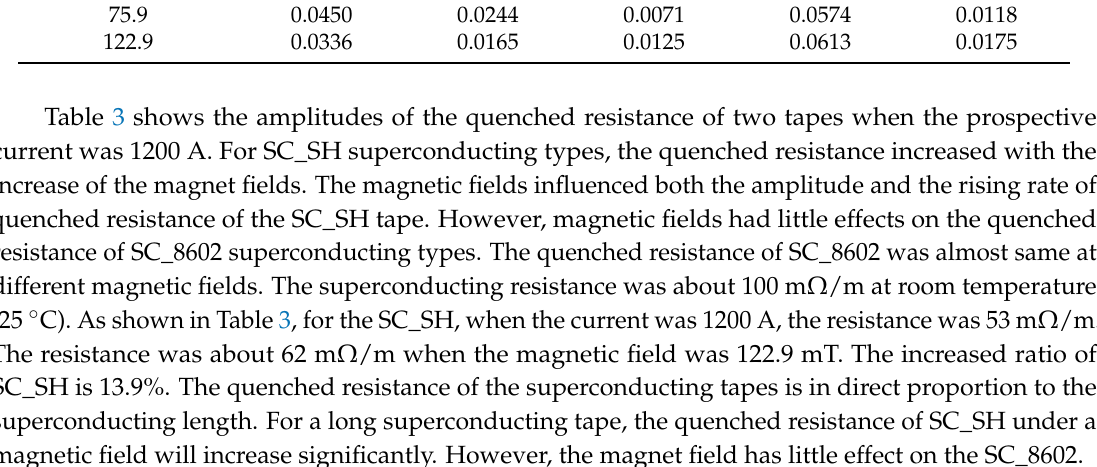
Table 3. Value of Quenched